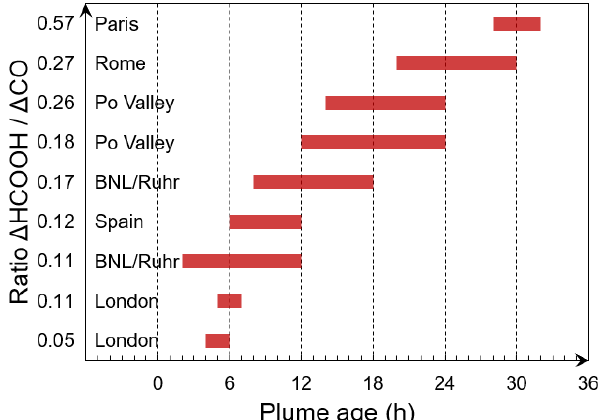
Figure 35. Observed enhancements of formic acid ( (cid:49) HCOOH) in MPC plumes relative to observed CO enhancements ( (cid:49) CO) as a function of plume age from HYSPLIT simulations. The correspond- ing city plume is indicated next to the